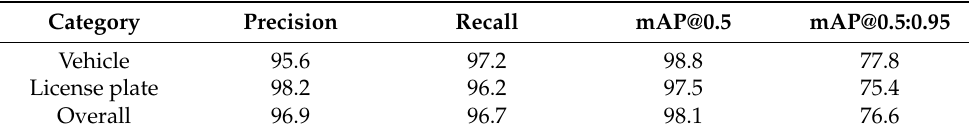
Table 3. The detection results of the proposed